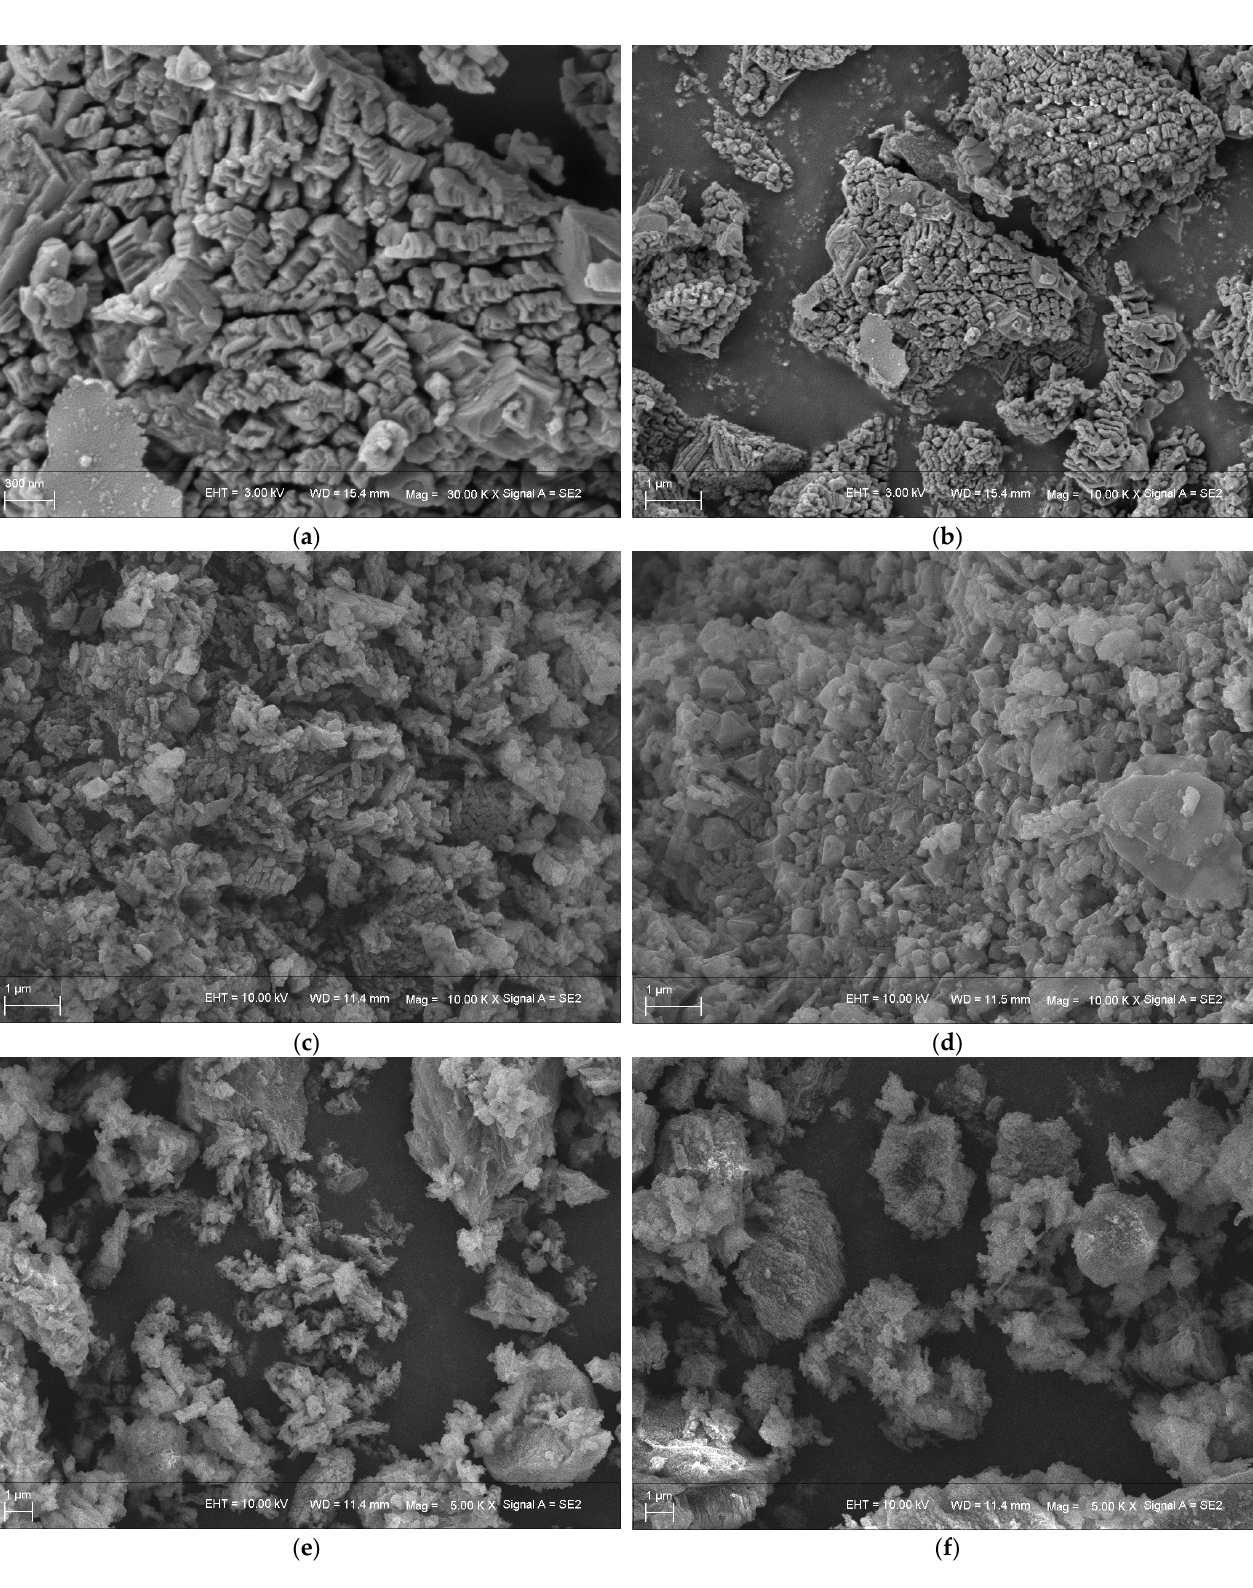
Figure 3. SEM images of calcined magnesite and ILs-modified magnesite with different magnifications: (( a ) calcined magnesite (300 nm); ( b ) calcined magnesite (1 μm); ( c ) [AEMIM]Br-modified magnesite (1 μm); ( d ) [APMIM]Br-modified magnesite (1 μm); ( e ) [AEMIM]BF 4 -modified magnesite (1 μm) and ( f ) [APMIM]BF 4 -modified magnesite (1 μm)).